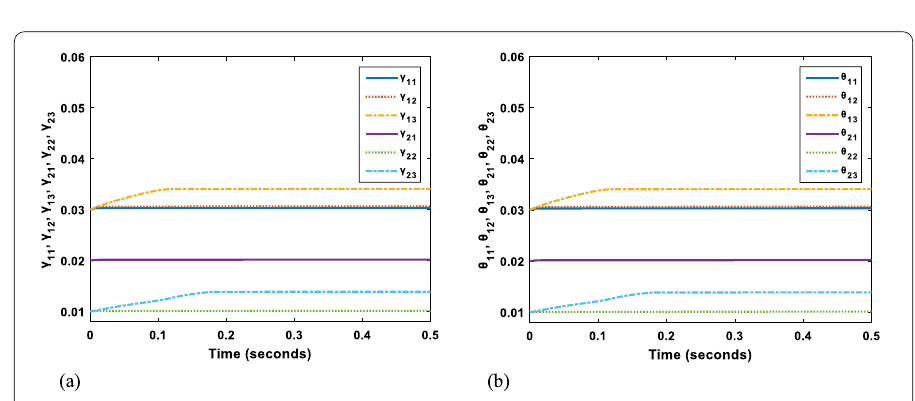
Figure 9 Estimation of adaptive parameters: ( a ) γ 11 ( t ), γ 12 ( t ), γ 13 ( t ), γ 21 ( t ), γ 22 ( t ), γ 23 ( t ) and ( b ) θ 11 ( t ), θ 12 ( t ),